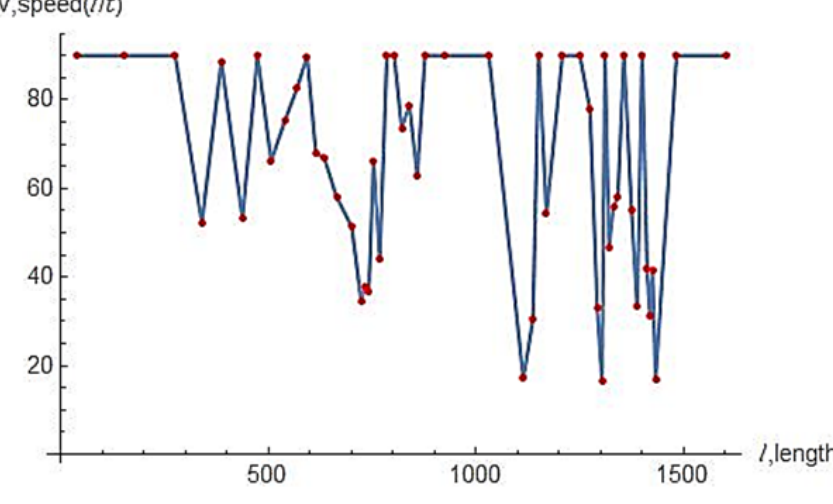
Figure 11. Design speed capped by average speed of 90 km/h